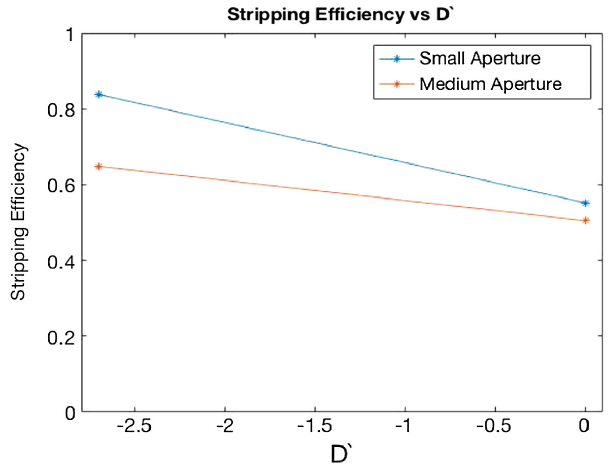
FIG. 26. Stripping efficiency with and without dispersion tailoring. The laser beam was 1 MW peak